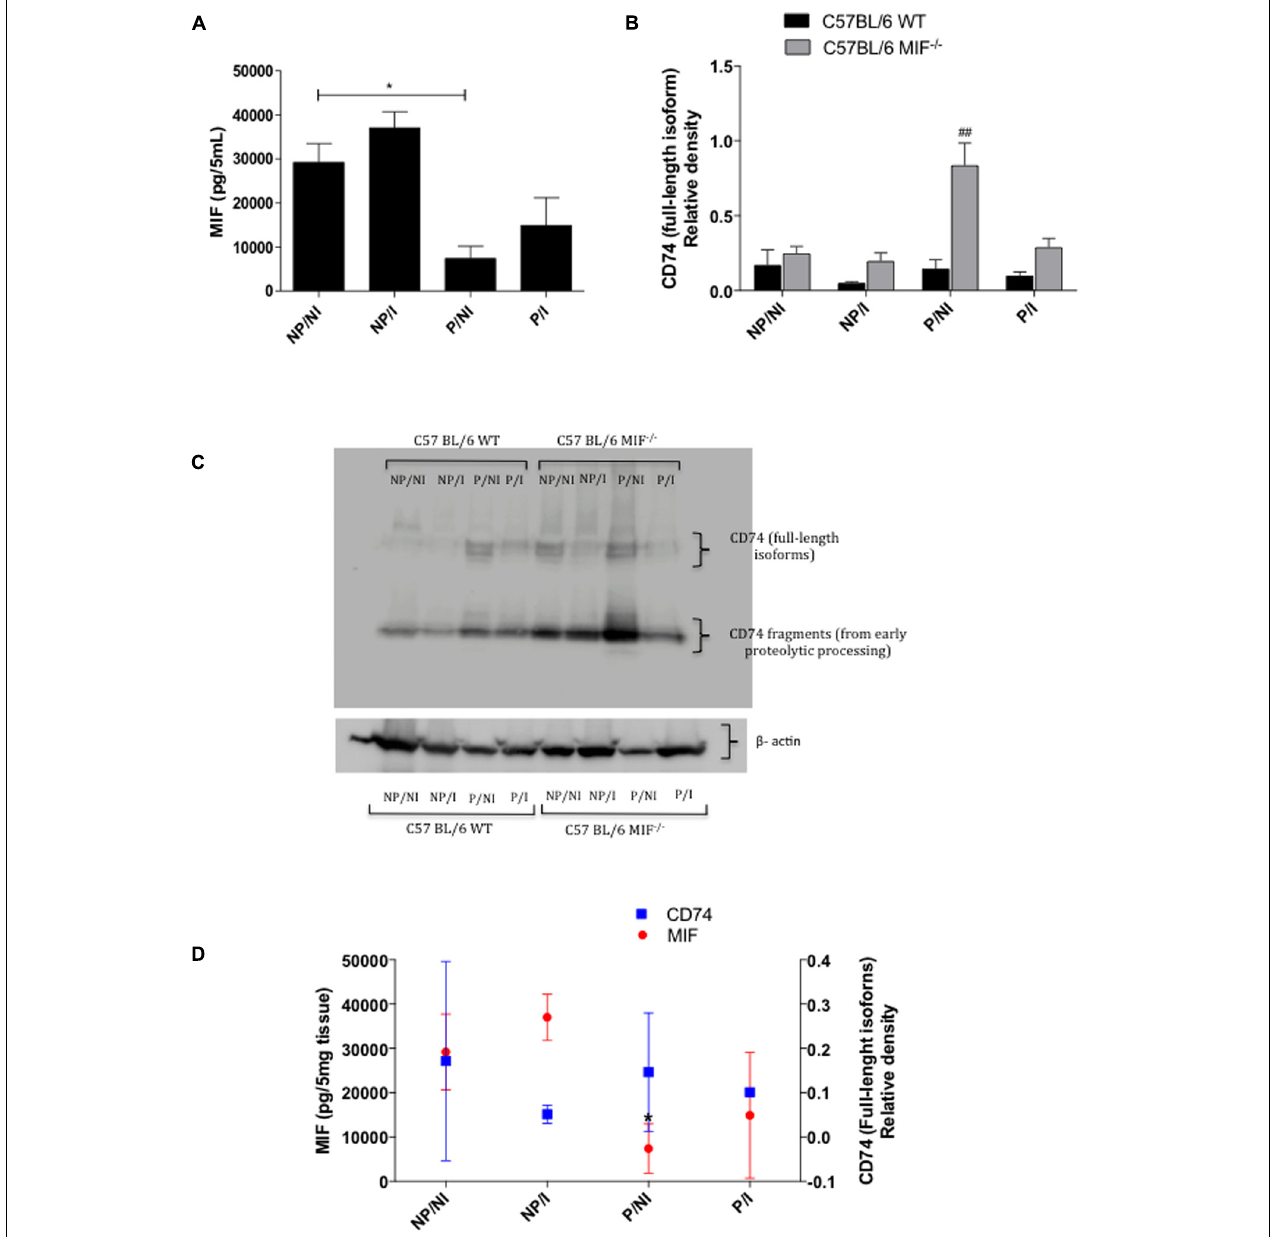
FIGURE 7 | (A) ELISA for measurement of MIF in uterus homogenates of pregnant and non-pregnant C57BL/6 WT mice orally infected by Toxoplasma gondii ( n = 5 animals per group). Uterus tissue samples were collected within 8 days of infection/pregnancy. Uterus tissues from non-infected pregnant and non-pregnant mice were used as controls. The homogenates were prepared in a concentration of 200 mg/mL. Data are expressed as the amount of cytokines (pg) present in 5 mg of tissue (pg/5 mg of tissue). NP/NI, non-pregnant/non-infected; NP/I, non-pregnant/infected; P/NI, pregnant/non-infected; P/I, pregnant/infected. (B) Relative density of CD74 expression (full-length isoforms) in the uterus homogenates from pregnant and non-pregnant MIF − / − and WT females infected or not by T. gondii. Densitometric analyses are expressed as relative density of the ratio between CD74 and β -actin bands. Data are presented as mean and SEM of uterus samples from five animals per group. # Significant differences between MIF − / − and WT in the same experimental condition ( ## P < 0.01). ∗ Comparisons between multiple experimental conditions within the same group (NP/NI, non-pregnant/non-infected; NP/I, non-pregnant/infected; P/NI, pregnant/non-infected; P/I, pregnant/infected) are indicated by bars ( ∗ P < 0.05). Data were compared by the Kruskal–Wallis test and Dunn’s multiple comparison post-test. (C) Representative blot for CD74 (full-length isoforms and fragments) and cropped blot for β -actin (42 kDa). All sample in the same gel were run simultaneously. Blots were probed with mouse anti-CD74 and then stripped and reprobed with mouse anti β -actin as a loading control. Full-length blots are reported. (D) Association between MIF levels and CD74 (full-length isoforms) expression in uterus homogenates from pregnant and non-pregnant C57BL/6 WT mice orally infected with T. gondii. Uterus tissues from non-infected pregnant and non-pregnant mice were used as controls. ∗ Asterisks indicate significant differences for MIF levels between non-infected pregnant and non-pregnant females ( ∗ P < 0.05). Data were compared by the Kruskal–Wallis test and Dunn’s multiple comparison post-test.